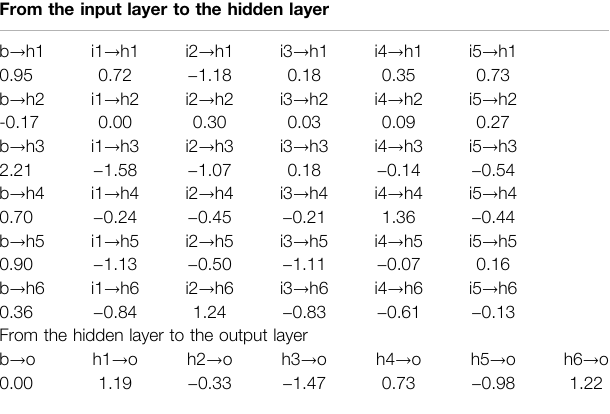
FIGURE 14 | ANN training performance (MATLAB-based